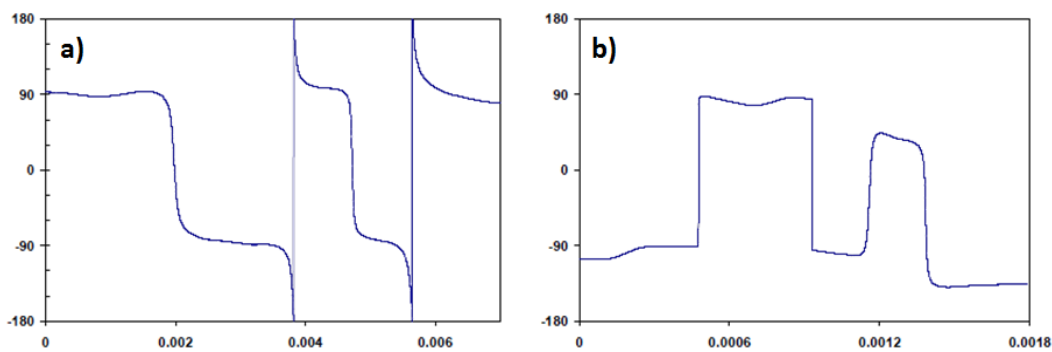
Figure 12. PSK communications signals for (a) Al-FBG and (b)